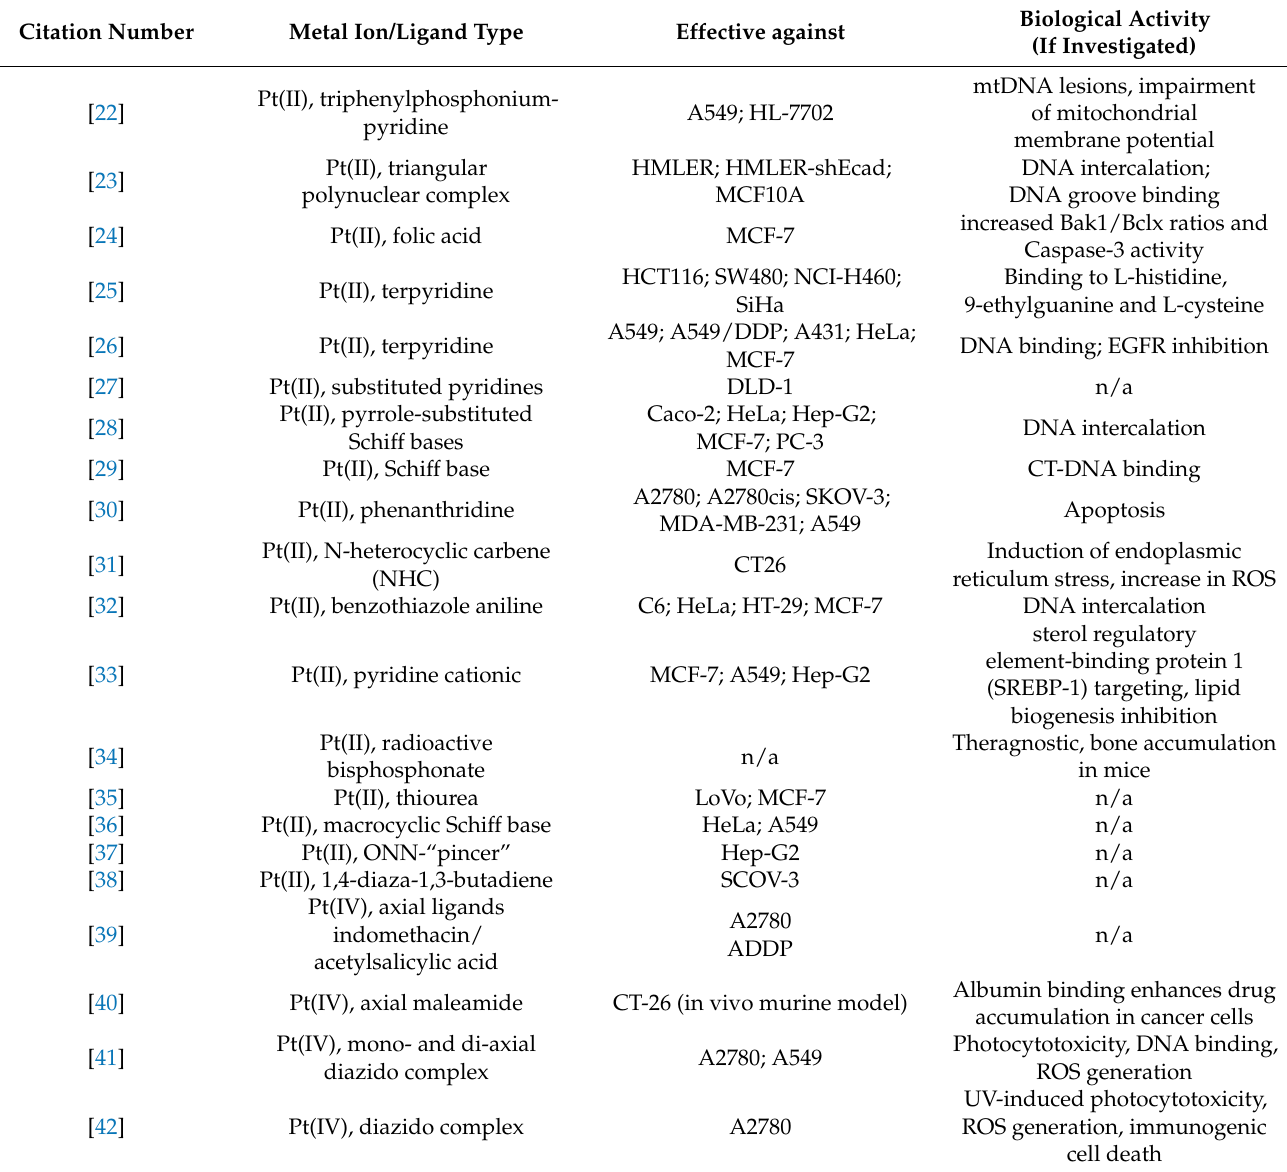
Table 1. Summary of the platinum complexes